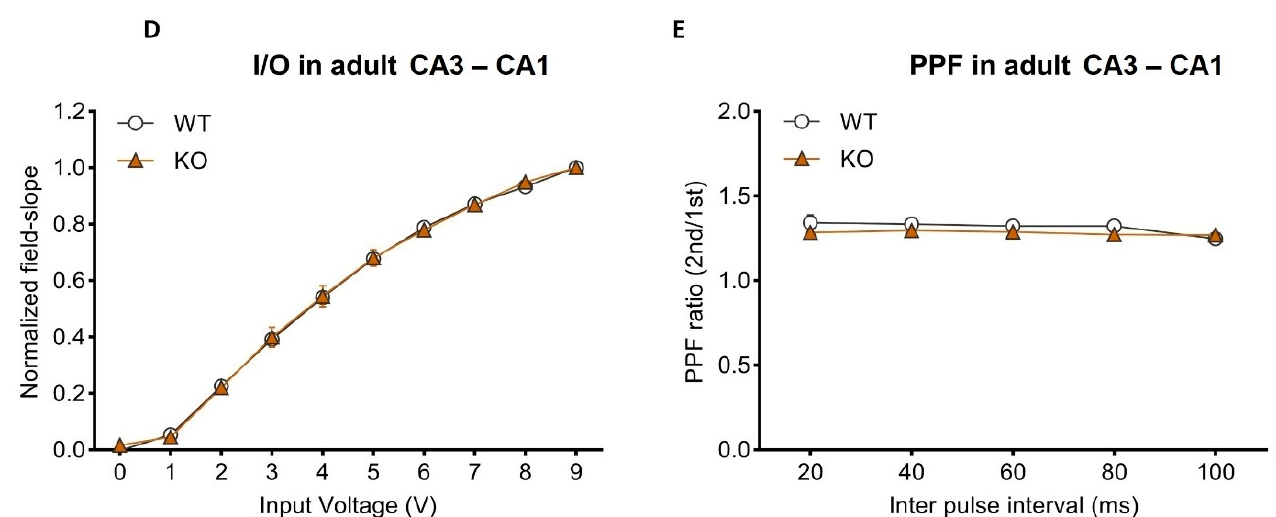
Figure 2. Unaltered basal synaptic transmission and paired-pulse facilitation in adolescent or adult hippocampal CA3–CA1 synapses of miRNA-132/212 knockout mice. ( A ) Schematic study design and experimental approach to study LTP induction at the Schaffer collateral output synapses. ( B ) Averaged field slopes vs. stimulation voltages (as derived from I/O protocols) for adolescent (PND 35–65) wild-type (WT; n = 16) and miRNA-132/212 − / − mice (KO, n = 12). Data showed no genotype differences (ns = p < 0.05; ANOVA (repeated measures) was followed by the Bonferroni test; error bars presented as SEM). ( C ) Averaged PPF ratios vs. increasing inter-pulse intervals. No differences are apparent between groups (ns = p < 0.05; ANOVA (repeated measures) followed by the Bonferroni test; error bars presented as SEM). ( D ) Averaged field slopes vs. increasing stimulation voltages (from I/O protocols) in mature-adult (PND 120–180) wild-type (WT, n = 11) and miRNA-132/212 − / − (KO, n = 9) slices. No statistical differences between genotypes were apparent (ns = p < 0.05; ANOVA (repeated measures) followed by the Bonferroni test; error bars presented as SEM). ( E ) Averaged PPF ratios vs. increasing inter-pulse intervals. No differences were detected between the groups (ns = p < 0.05; ANOVA (repeated measures) was followed by the Bonferroni test; error bars presented as SEM). PPF: Paired-Pulse Facilitation; PND: postnatal day. For I/O, ANOVA for adolescent cohort indicated an effect of stimulation voltage ( p < 0.0001, F (1.232, 32.03) = 2301) without genotype effect ( p = 0.9885, F (1, 26) = 0.0002112), and for adult cohort a predicted main significant effect of input voltage ( p > 0.0001, F (1.451, 26.12) = 1286) but no significant effect of genotype ( p = 0.9042, F (1, 18) = 0.01490). For paired-pulse-induced plasticity; (ANOVA for adolescent cohort revealed main effect of inter-pulse interval ( p < 0.0001, F (2.507, 65.19) = 39.82) without genotype effects ( p = 0.2207, F (1, 26) = 1.575); without effects of the time interval between pulses ( p = 0.2253, F (1.275, 22.94) = 1.585) and no effects of the genotype ( p = 0.2561, F (1, 18) = 1.376) for the for adult